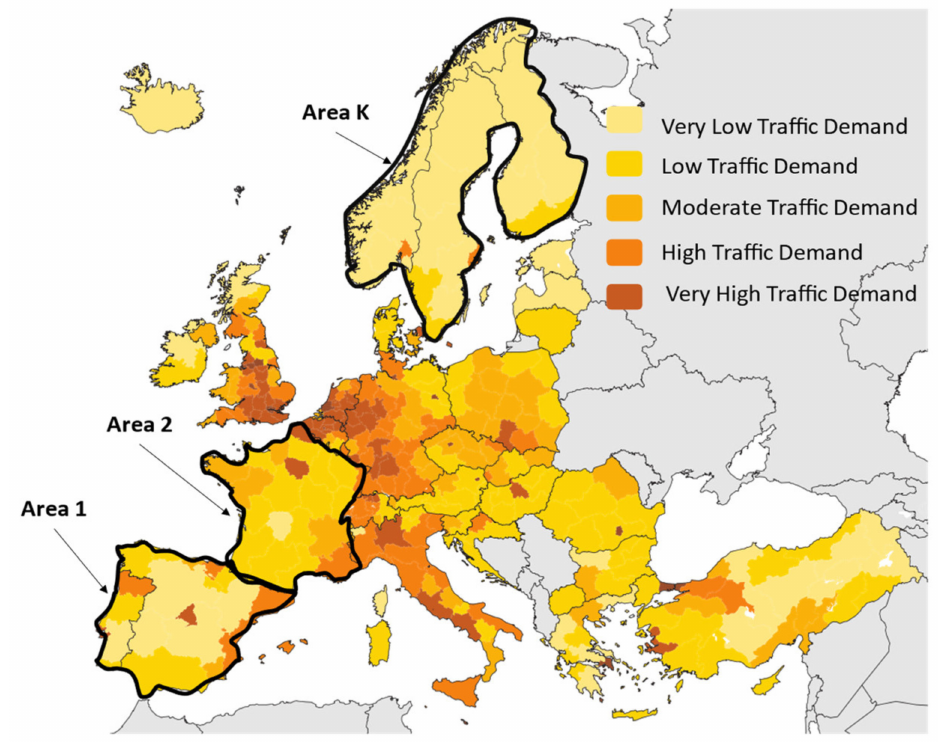
Figure 7. Study of the traffic demand in the service area to be divided into smaller areas according to the traffic demand based on population density